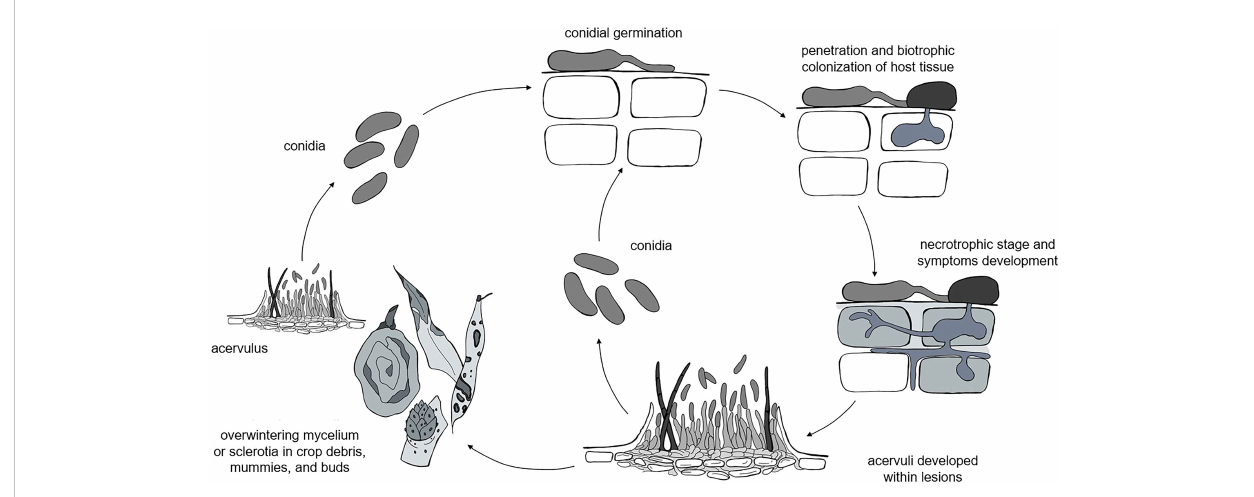
FIGURE 1 The general life cycle of Colletotrichum spp. as considered in the model: the pathogen overwinters as mycelia or sclerotia in different plant residues, which produce acervuli that in turn produce primary conidia. Infections caused by rain-dispersed conidia develop into lesions, which develop acervuli that produce conidia for secondary infection